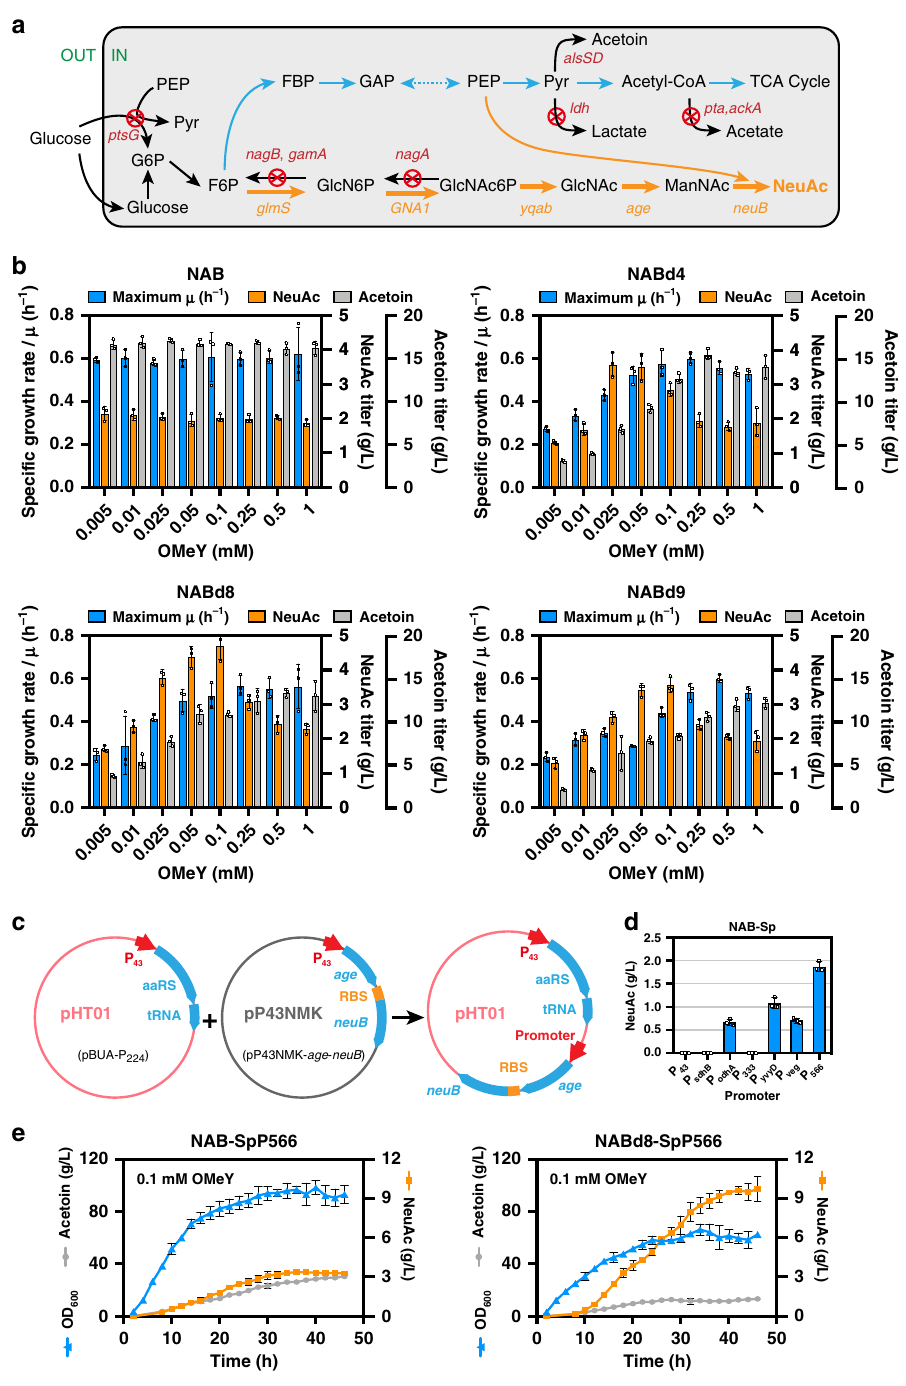
Fig. 5 Balancing cell growth with biosynthesis of N -acetylneuraminic acid (NeuAc). a NeuAc biosynthetic pathways in B. subtilis . G6P, Glucose-6P; F6P, Fructose-6P; FBP, Fructose-1,6-2P; GAP, glyceraldehyde-3-P; PEP, phosphoenolpyruvate; GlcNAc, N-acetylglucosamine; ManNAc, N-acetylmannose. b Fermentation ef fi ciencies of engineered B. subtilis strains at different O -methyl-L-tyrosine (OMeY) concentrations. c Amplifying gene age and neuB from plasmid pP43NMK and inserting into pBUA-P 224 under the control of different promoters. d NeuAc production of seven single-plasmid NeuAc biosynthesis strains. e Fermentation ef fi ciencies of NAB-SpP566 and NABd8-SpP566 in a 3-L fermenter. All the data are expressed as the mean ± SD from three ( n = 3) biologically independent replicates. Source data underlying ( b ), ( d ), ( e ) are provided as a Source data fi